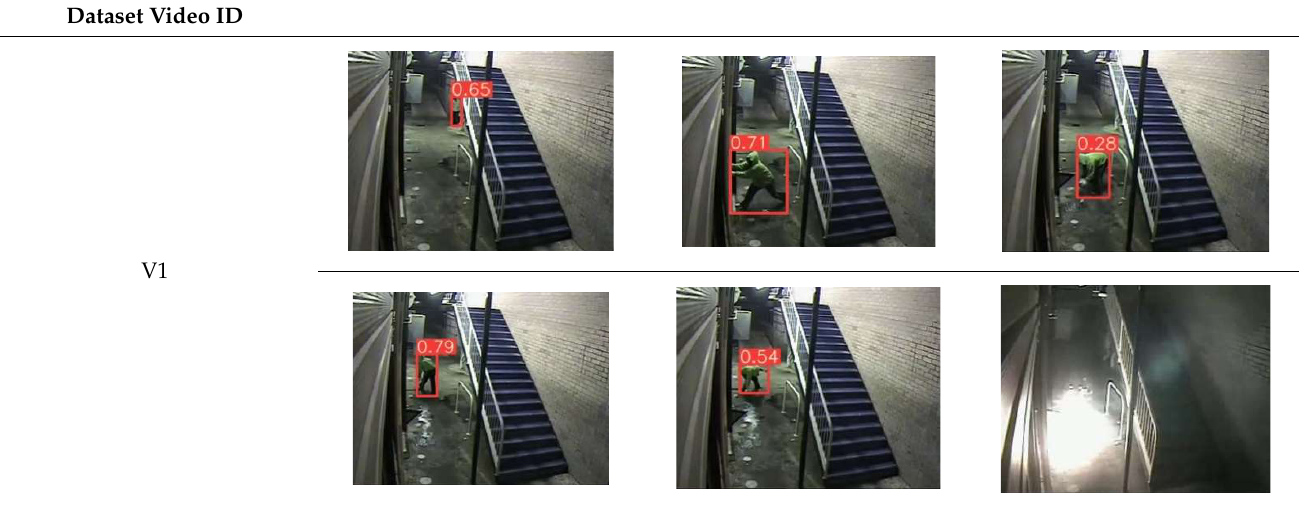
Table 4. Qualitative person detection results per selected video via the pre-trained YOLOv5s.